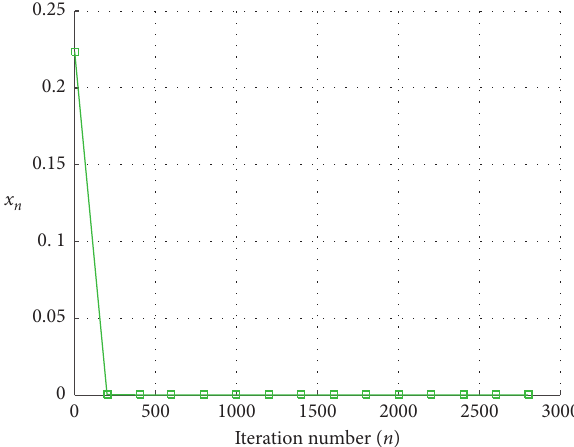
Figure 2: Convergence of x